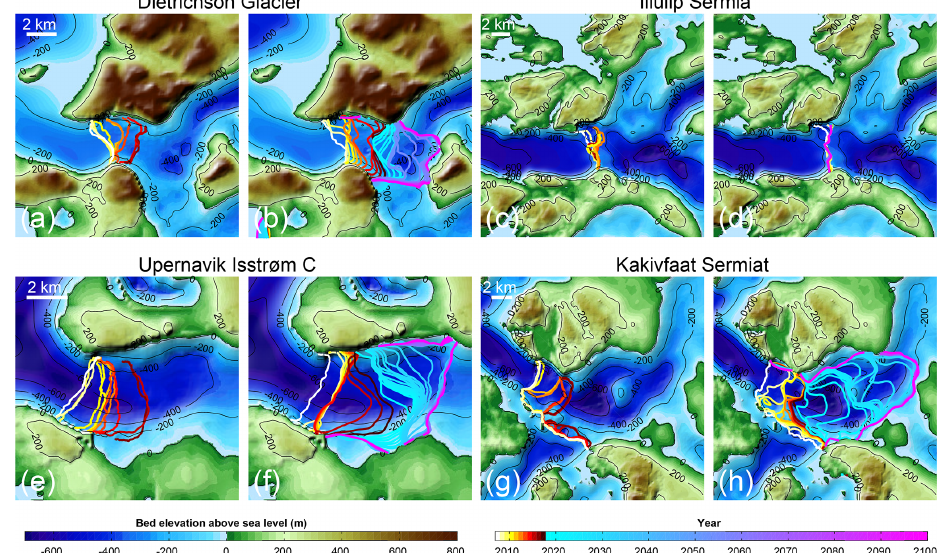
Figure 4. Observed (a, c, e, g) and modeled (b, d, f, h) ice front position for Dietrichson Gletscher (a, b) , Illulip Sermia (c, d) , Upernavik Isstrøm C (e, f) , and Kakivfaat Sermiat (g, h) under current conditions ( e T + 0 ◦ C, q sg × 1). Yellow to red lines are annual ice front position from 2007 to 2017, and light blue to pink are the model projections for 2017 to